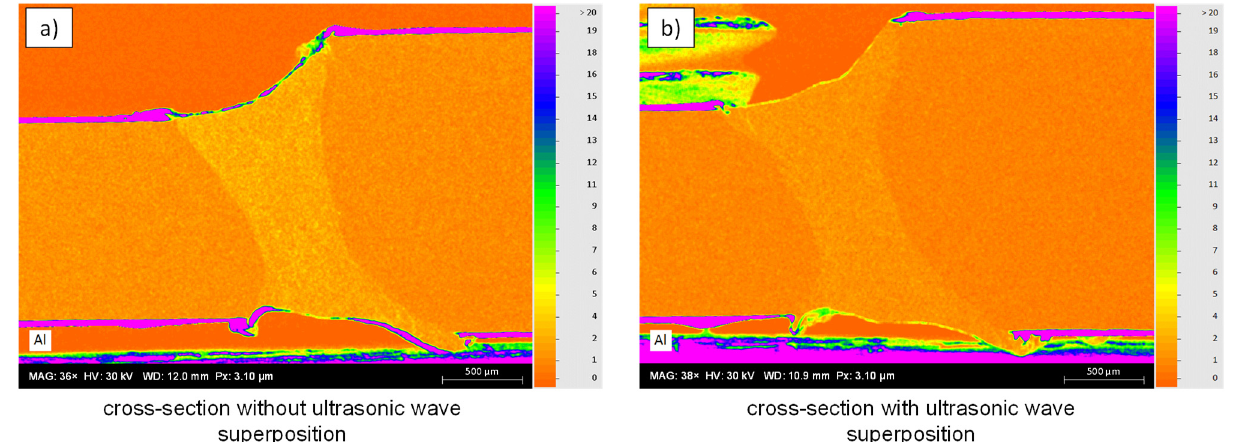
Figure 9. Comparison of EDS-analysis for aluminum in a false color image (0–9 wt.%) on welded tailored blanks. ( a ) depicts the cross-section obtained by welding without ultrasonic superposition and ( b ) with ultrasonic